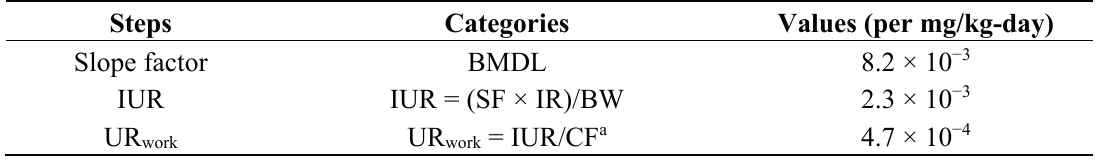
Table 2. Unit risk for carcinogenic dose-response assessment of